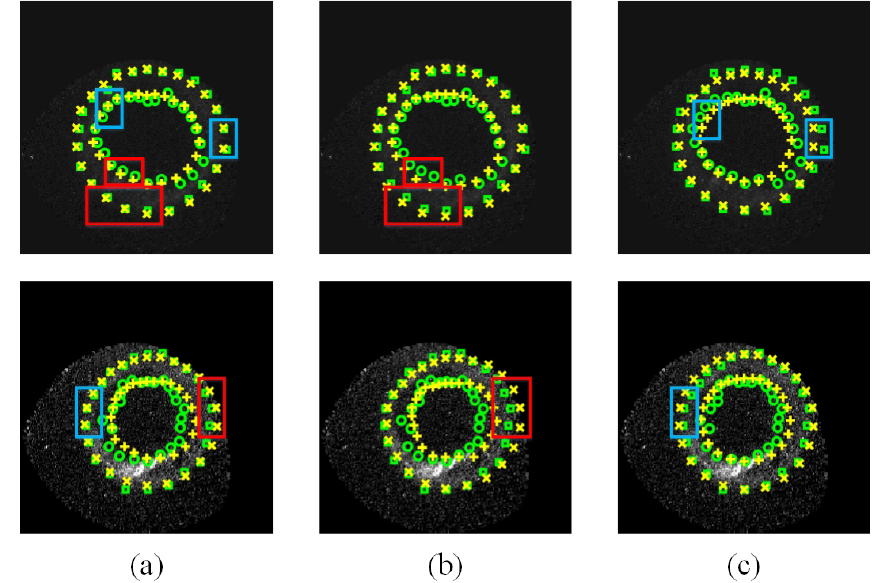
Figure 4. The different subjective results based on different methods. (a) The subjective results predicted by our method, (b) the subjective results predicted by the BP network, and (c) the subjective results predicted by the Yang et al. (2016)